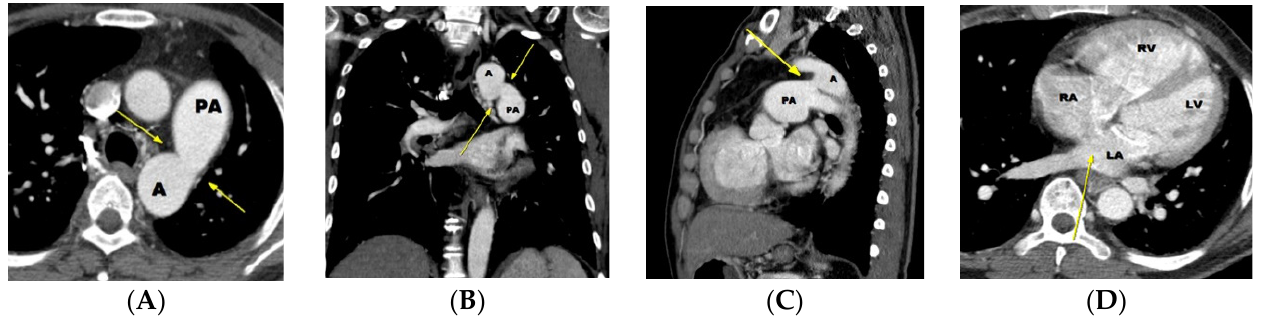
Figure 4. A case of PDA with Eisenmenger syndrome initially diagnosed by non-ECG gated chest CT. Moderate to large sized PDA (window shaped type B ) (arrows) is noted on an axial ( A ), coronal ( B ), and sagittal ( C ) CT image. A and PA indicate aorta and pulmonary artery, respectively. A possible discontinuity (not atrial septal defect, but patent foramen ovale) is noted in the inter-atrial septum, but is not definite in the absence of ECG-gating (arrow on D ). Note enlargement of the right atrium and ventricle due to Eisenmenger syndrome. Prior transthoracic echocardiography (obtained on seven occasions) failed to diagnosis the PDA over a period of 15 years, resulting in delay in diagnosis and obviating the opportunity for surgical correction. On echocardiography, the increased pulmonary artery pressure was falsely assumed to be due to an atrial septal defect. In fact, a large atrial septal defect is typically not an associated abnormality in patients with a large PDA because the presence of large atrial septal defect would trigger closure of the PDA. This case demonstrates the value of CT identification of PDA in some cases of a large PDA. LA, LV, RA, and RV indicate left atrium, left ventricle, right atrium, and right ventricle, respectively.